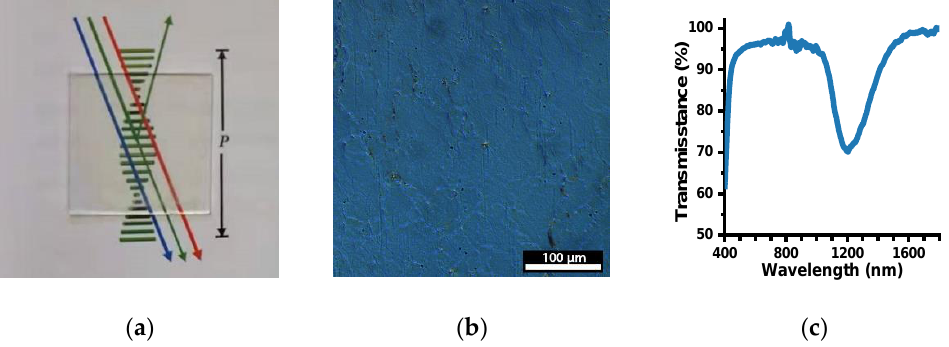
Figure 4. ( a ) Image of a fully-cured TP coating at room temperature, with a colorful image as background showing good visible light transparency. ( b ) Polarizer microscopy (POM) image of a fully-cured TP coating at room temperature (transmission mode), showing a planar aligned cholesteric texture. The bluish color might be due to the reduced efficiency of the polarizers. ( c ) Transmission spectrum of the fully cured coating at room temperature, after the removal of CM.